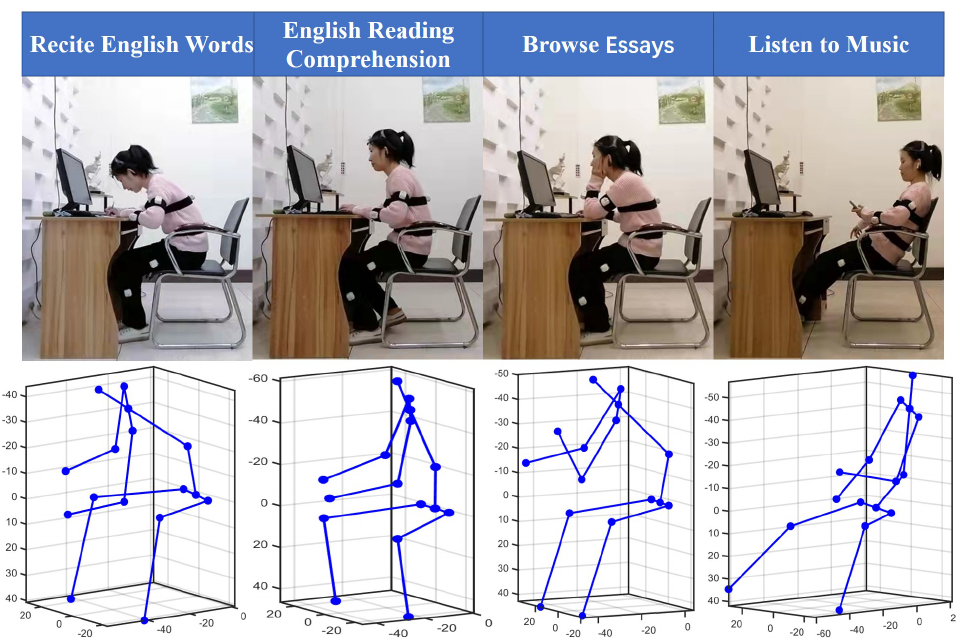
Figure 16. Participant’s posture of four tasks in the experiment. Table 4. Working condition feature